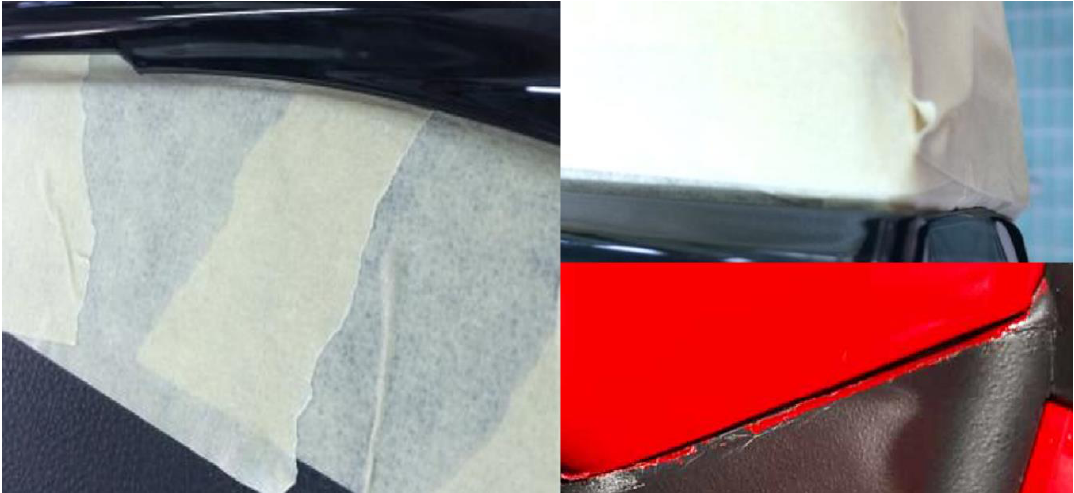
Figure 25. Painting process using masking tape.